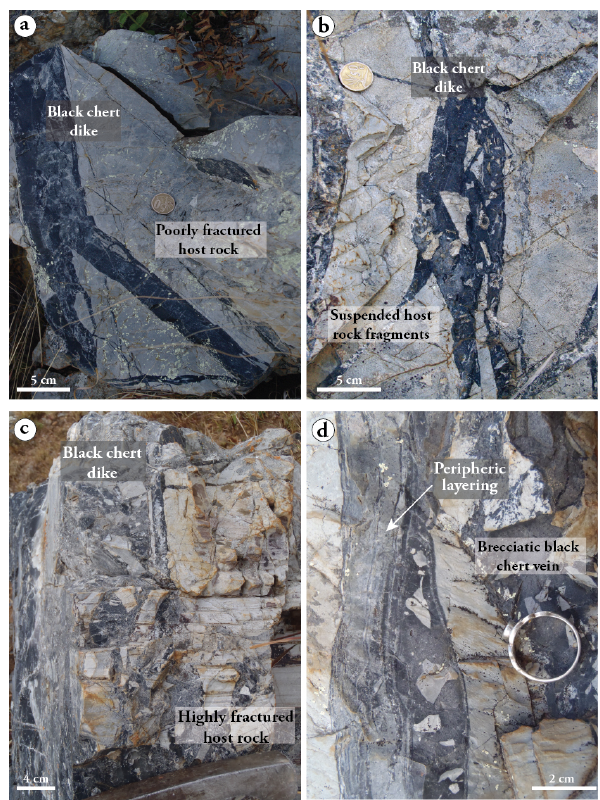
Figure 4. Main types of dikes encountered in the Barite Valley syn- cline with degree of fracturing increasing from photo (a) to photo (c) . The fractures have straight and sharp (a) to irregular bound- aries (c) . They contain variable amount of country rock fragments embedded in a black chert matrix, leading to clast-supported (c) or matrix-supported (b) textures in outcrop. Internal layering (d) is common and indicates multiple fluid injections.